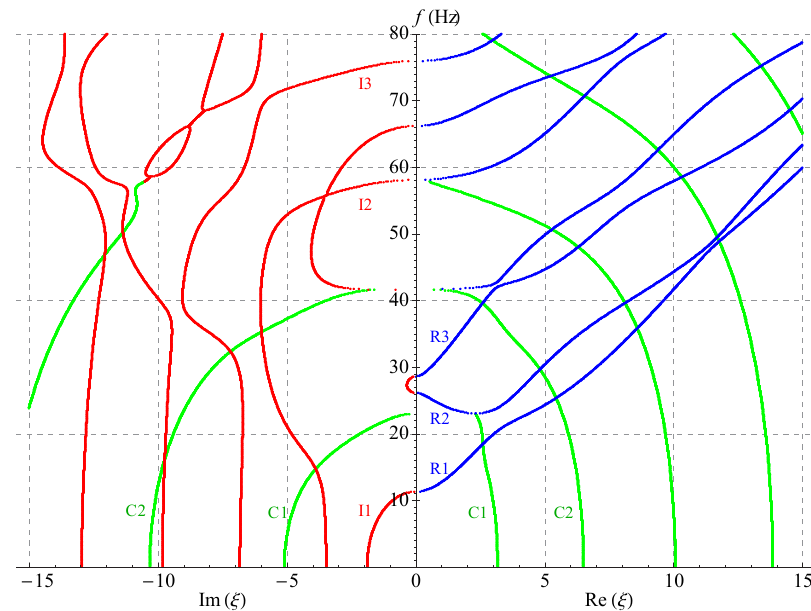
Figure 8. Two-dimensional full frequency spectra without considering electric field ( n =